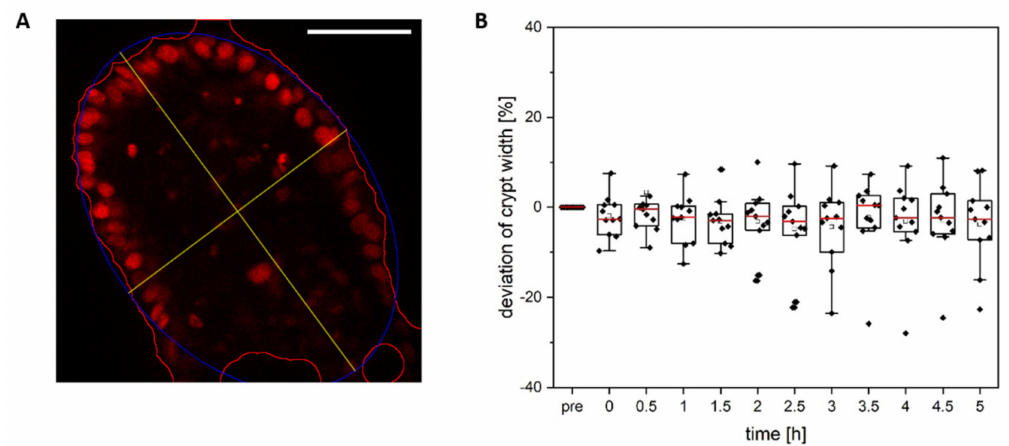
Figure 7. Analysis of the crypt form. ( A ) Using a self-written Fiji macro, which approximates the crypt circumference using an ellipse, the dependence of the crypt width after single cell ablation was determined over time. ( B ) The crypt form was not significantly altered over time ( n = 11). Scale bar 50 µ